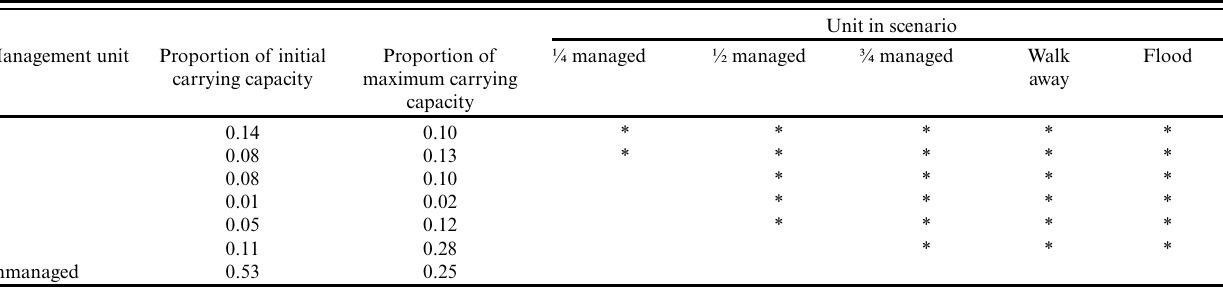
Unit in scenario